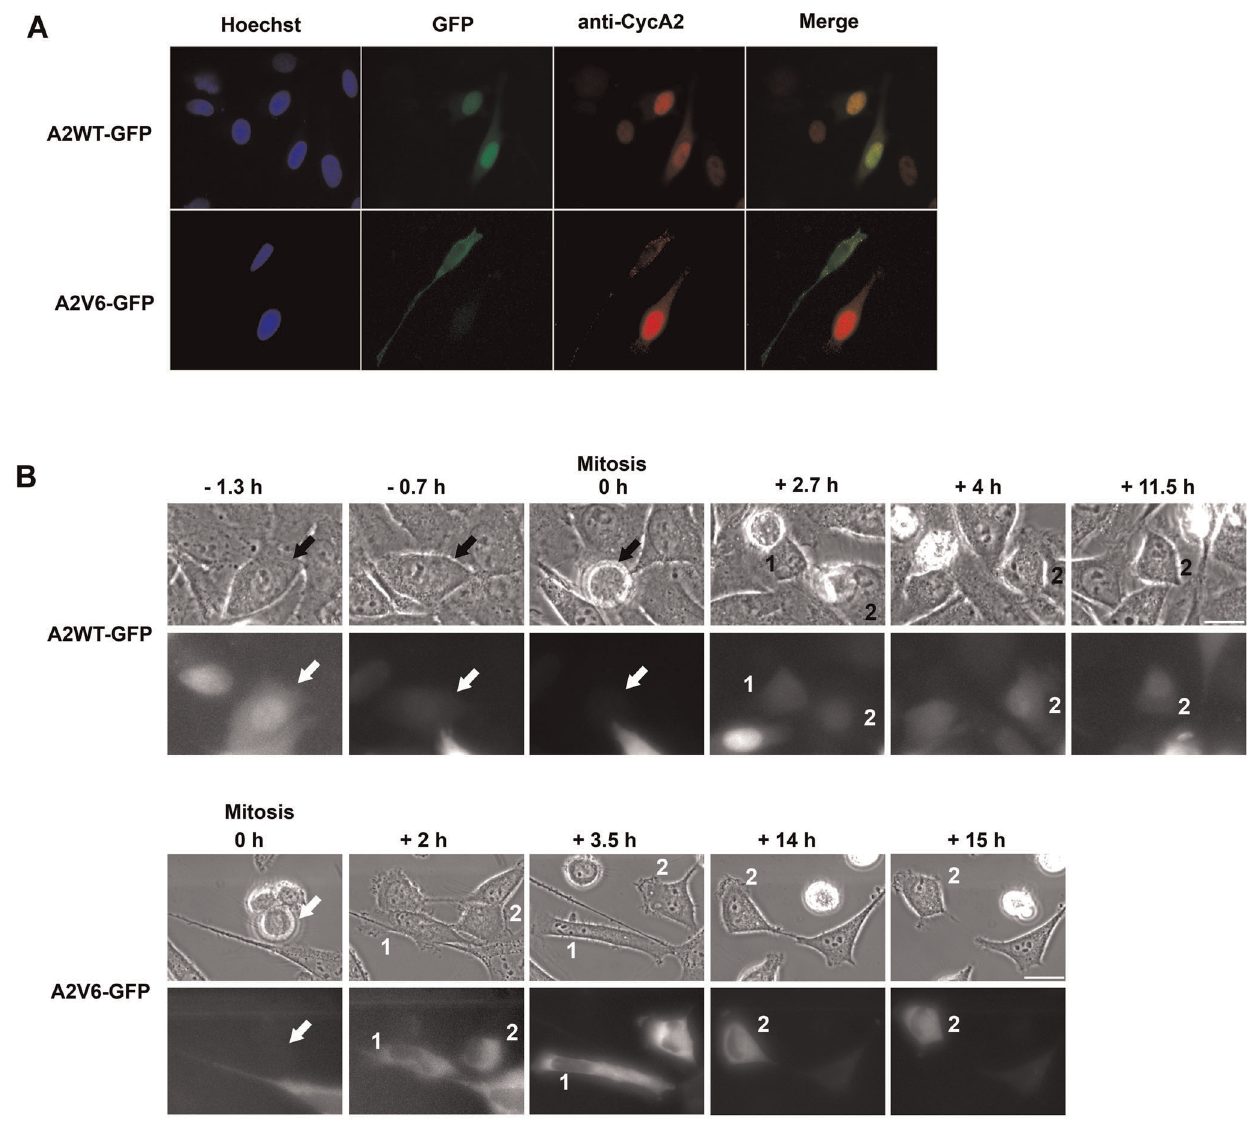
Figure 2. Cytoplasmic localization of A2V6-GFP during the cell cycle. HeLa cells were transfected with wild-type cyclin A2-GFP (A2WT-GFP) or Intron 6-retaining cyclin A2-GFP (A2V6-GFP) vectors. ( A ) Immunofluorescence images of transfected HeLa cells using anti-GFP (green) and anti- cyclin A2 (red) antibodies. Nuclei (blue) were counterstained with Hoechst dye 33258. The A2V6-GFP protein is located in the cytoplasm of transfected cells. No endogenous cyclin A2 is detected in cells expressing the A2V6 protein. ( B ) Time-lapse imaging of A2WT- and A2V6-GFP during a cell cycle. Upper panel: Phase contrast microscopy. Lower panel: Fluorescence microscopy. Arrow: parent cell. Labels 1 and 2: daughter cells. Wild- type cyclin A2-GFP is accumulated in G2 nuclei ( 2 1.3 h), degraded in mitosis and reappears mostly in the nuclei in S phase, like endogenous cyclin A2. In contrast, A2V6-GFP remains in the cytoplasm throughout the cell cycle. Scale bar: 20 m m.